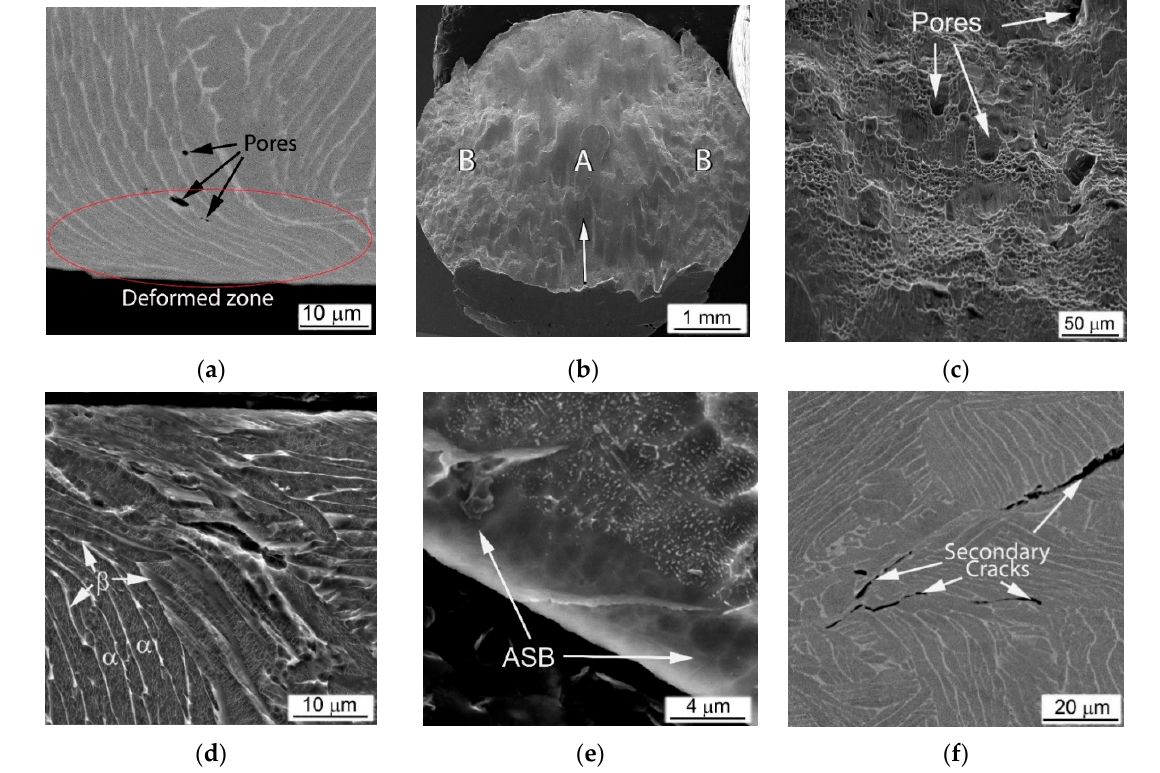
Figure 9. Microstructure ( a , d – f ), and fracture surface ( b , c ) of Ti64BEPM specimens tested with the strain rates: ( a ) 2220 s − 1 (not broken), and ( b – e ) 2390 s − 1 (broken). ( a , d ) Zone I, ( e ) Zone II, ( f ) Zone III. SEM, ( a , f ) SE, ( b – e ) BSE. The specimens were compressed along the vertical axis as shown in Figure 8, and images in ( a , d – f ) are aligned with their vertical axis along with the acting external load like in Figure 8.